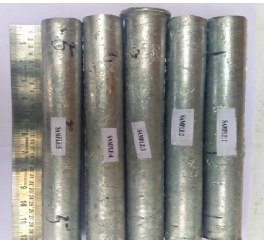
Figure 2: LM6 Al alloy hybrid composites samples.